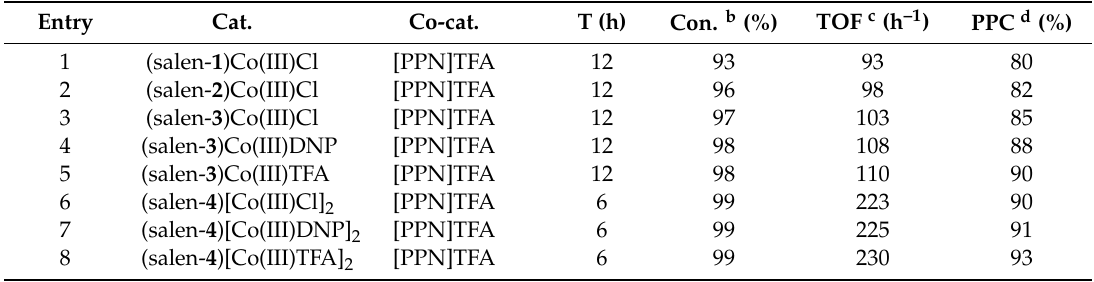
Table 1. (Salen)Co(III)X catalyzed PO / CO 2 copolymerization a